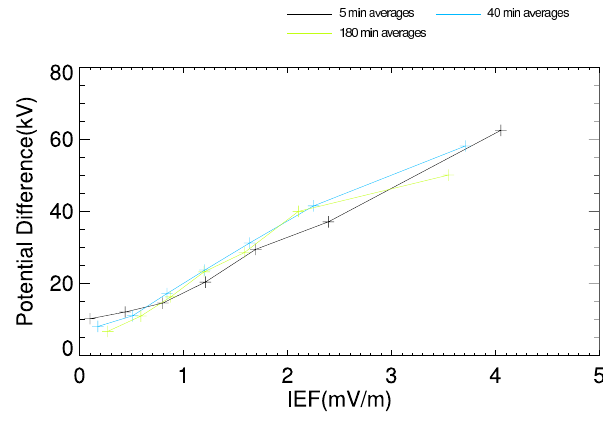
Fig. 10. The relation between IEF and potential difference at 2 ≤ L ≤ 10 in our statistics. Potential differences are calculated for three averaging intervals of the IEF: 5, 40, and